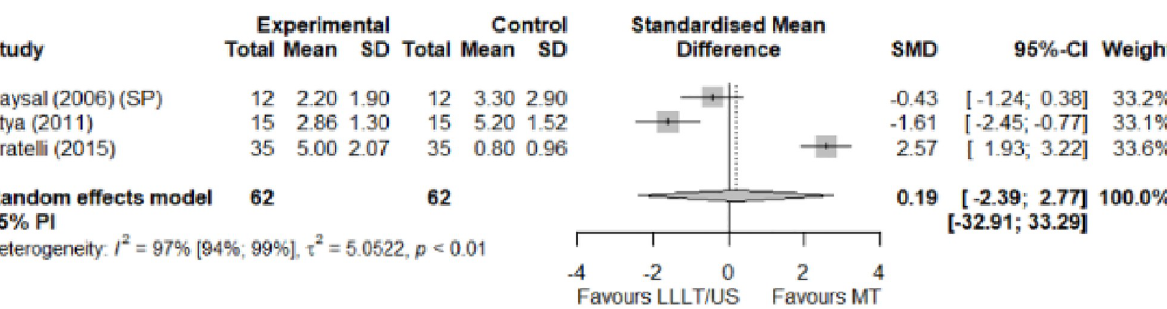
Fig 13. Analysis—Electrophysical modalities versus manual therapy (pain). Studies delivering modalities with a splint were marked as (SP).